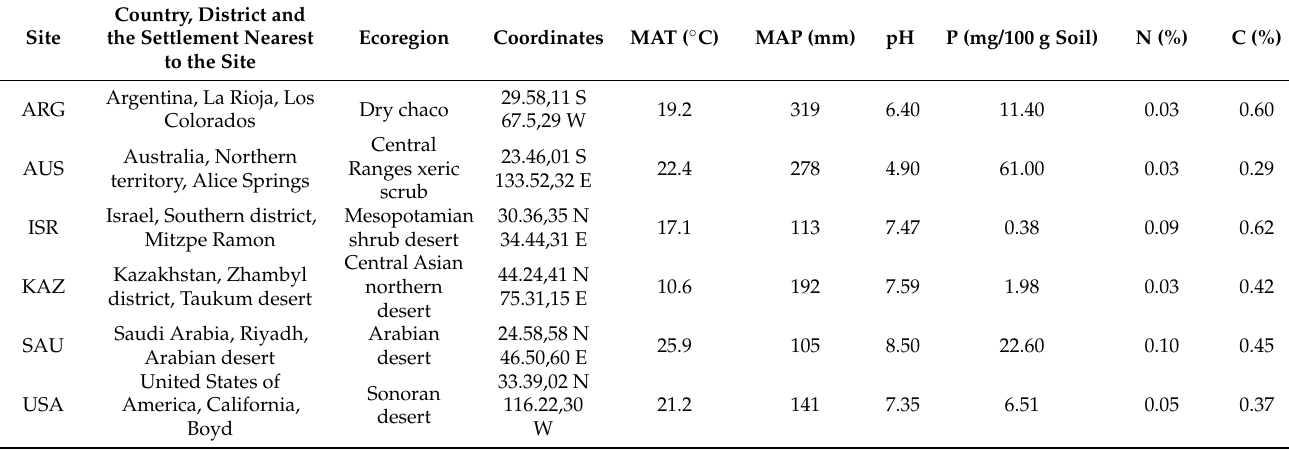
Figure 1. Sampling locations and desert and arid shrubland biomes colored yellow. Table 1. Study site characteristics. Mean annual temperature (MAT), mean annual precipitation (MAP), soil organic carbon (C), total nitrogen (N), available phosphorus (P), Argentina (ARG), Australia (AUS), Israel (ISR), Kazakhstan (KAZ), Saudi Arabia (SAU) and United States of America (USA). Ecoregion is from